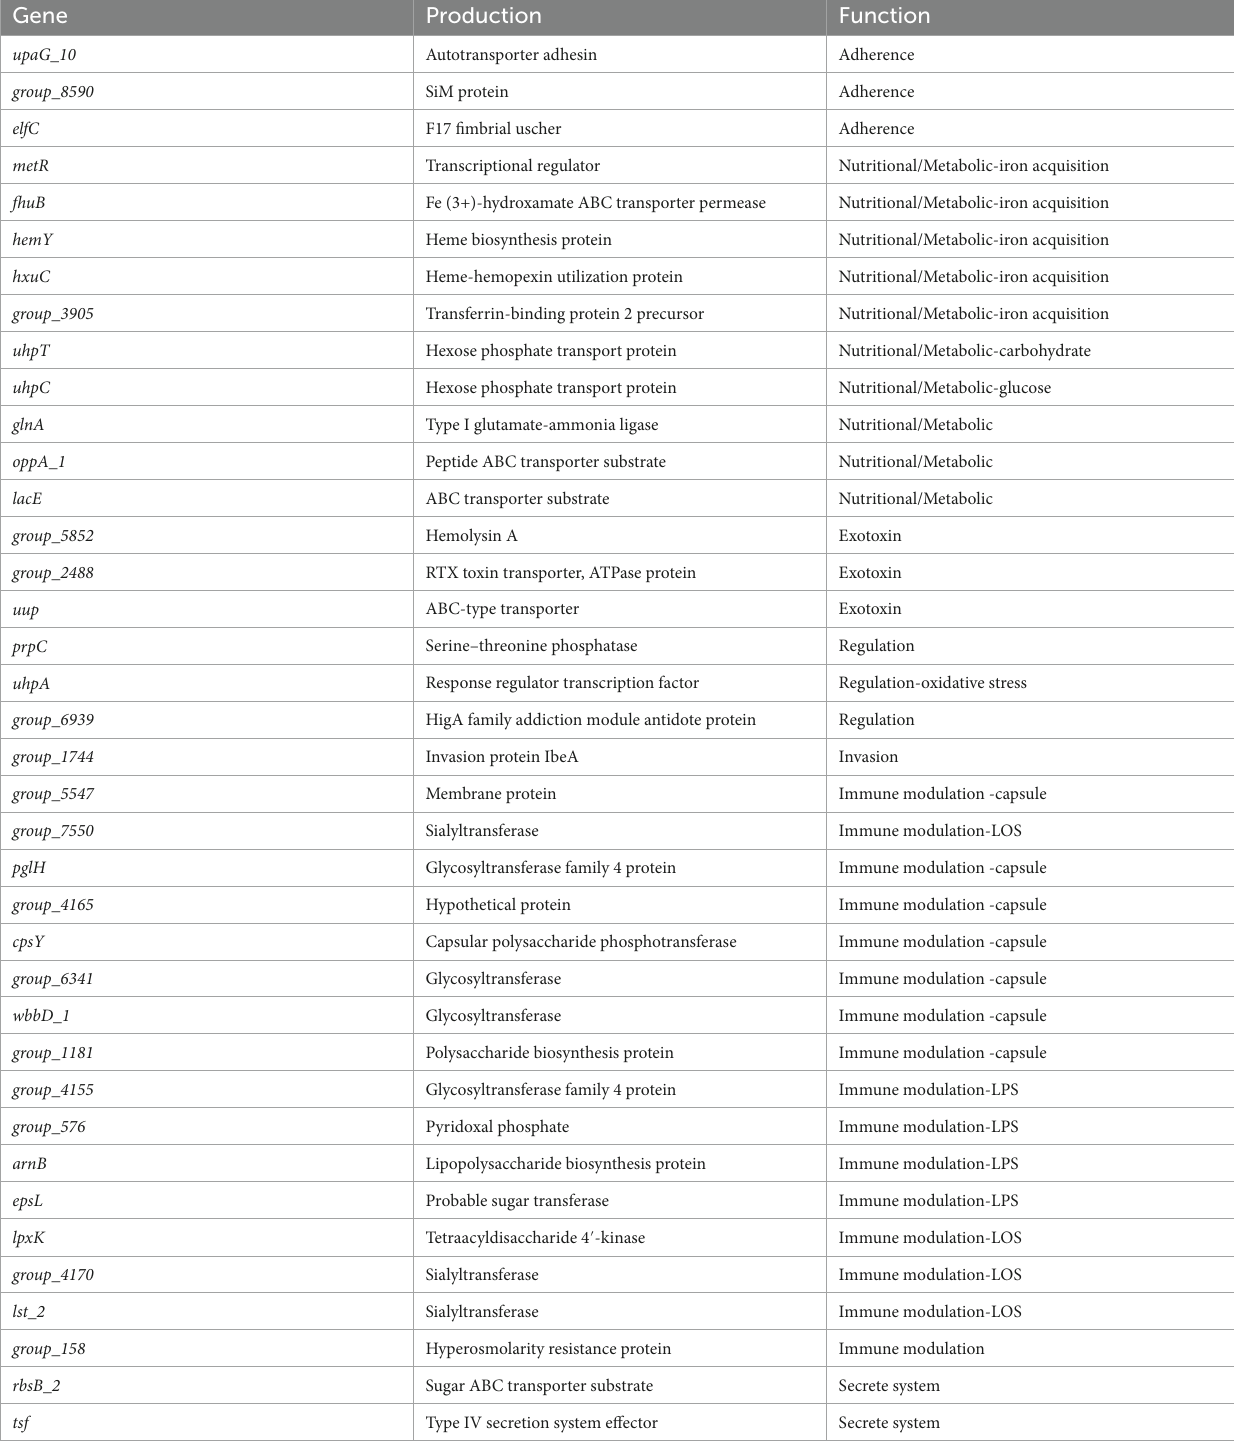
TABLE 8 VFDB annotation of strong virulence-associated genes.